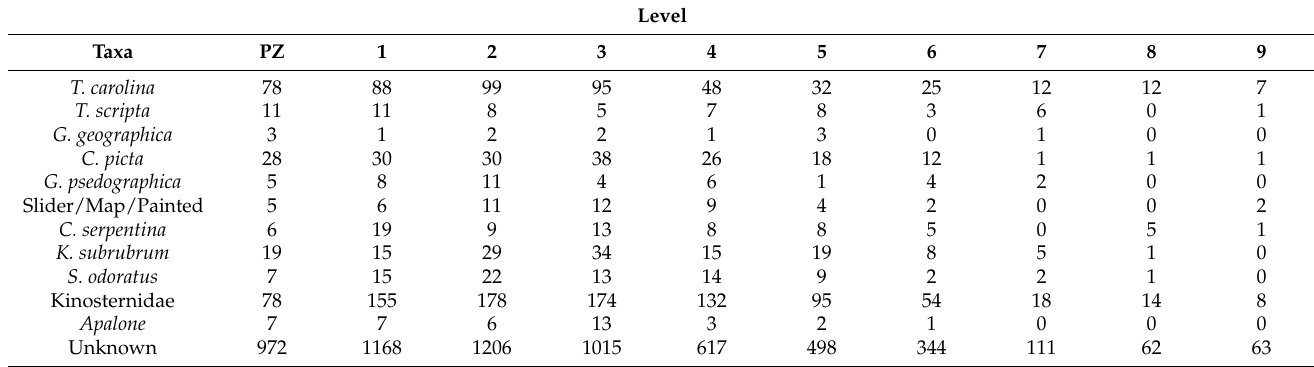
Table 4. Turtle taxon counts by level.